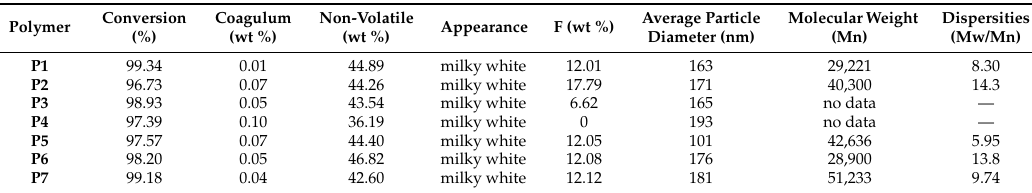
Table 2. Results of the emulsion polymerizations.